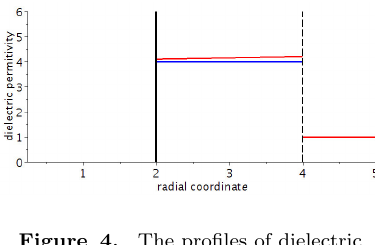
Figure 5. The profiles of dielectric permittivity: ε c + ρ − 2 (red curve) and 2 ε c (blue curve).